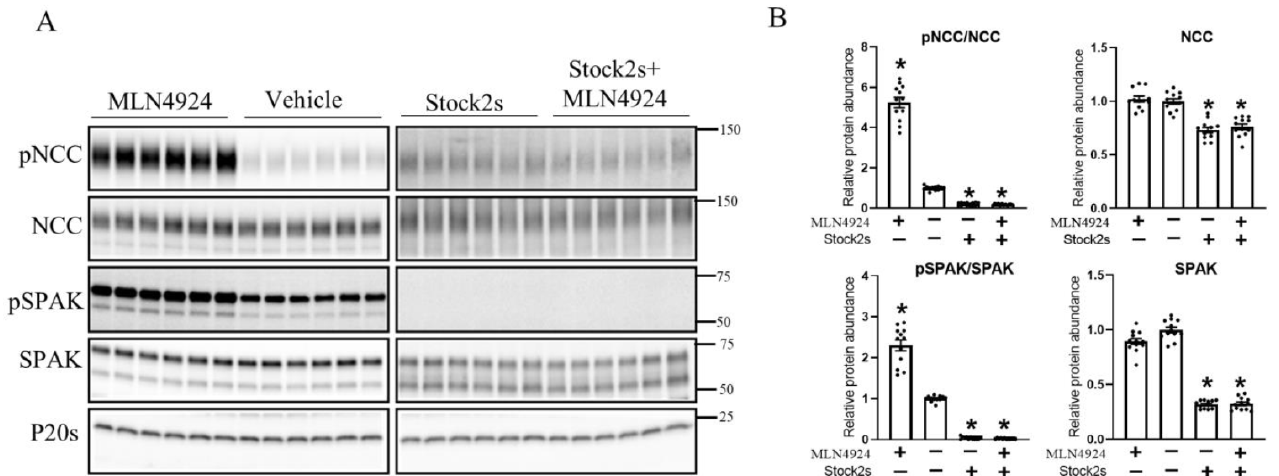
Figure 6. MLN4924 alters NCC phosphorylation via the WNK–SPAK pathway. ( A ) Representative immunoblots of pNCC, NCC, pSPAK, SPAK, and P20s in isolated renal tubules that were incubated with either the cullin inhibitor (MLN4924), vehicle, WNK inhibitor (Stock2s), or both MLN4924 and the WNK inhibitor. Molecular weight markers (kDa) are shown on the right. ( B ) Summarized relative protein abundance data. Each dot represents value from an individual well of independent tubules and each bar represents mean ± SEM obtained from two independent experiments ( n = 12). * indicates p < 0.05 relative to